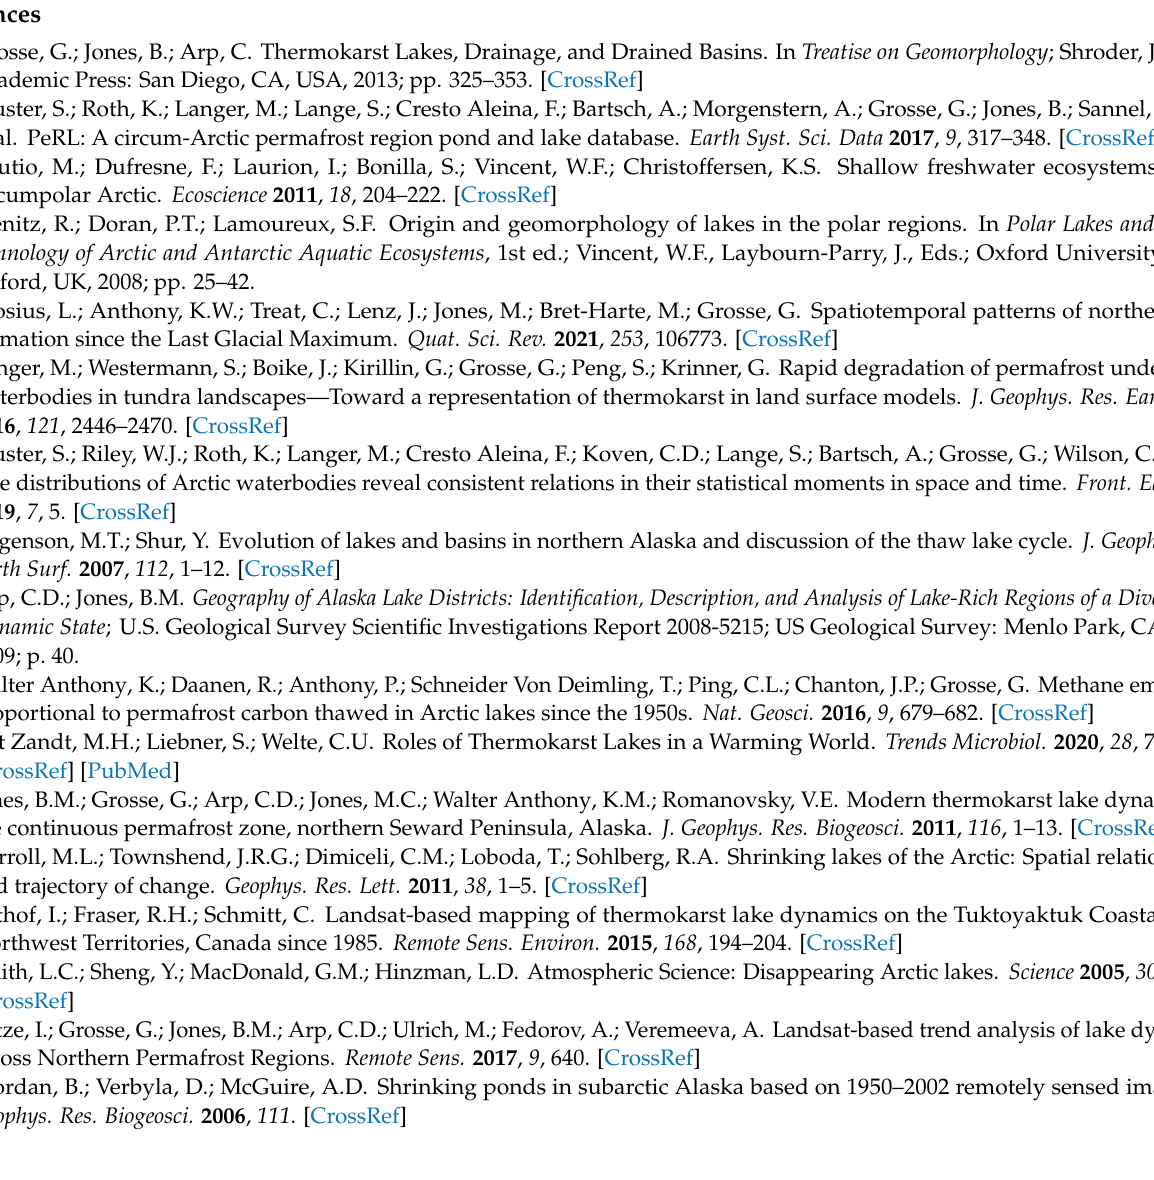
Figure A3. Examples of error sources for the incorrect derivation of water bodies and/or shoreline movement rates. ( A ) The duplicates mentioned in Section 3.1.6. Subsequent images show the underestimation of water surface area due to shallow water depths ( B ), sunglint ( C ) and unidentified connections between lakes ( D ) and the overestimation by including adjacent moist patches ( E ) (Background high-resolution imagery copyrighted by DigitalGlobe, 2006 &